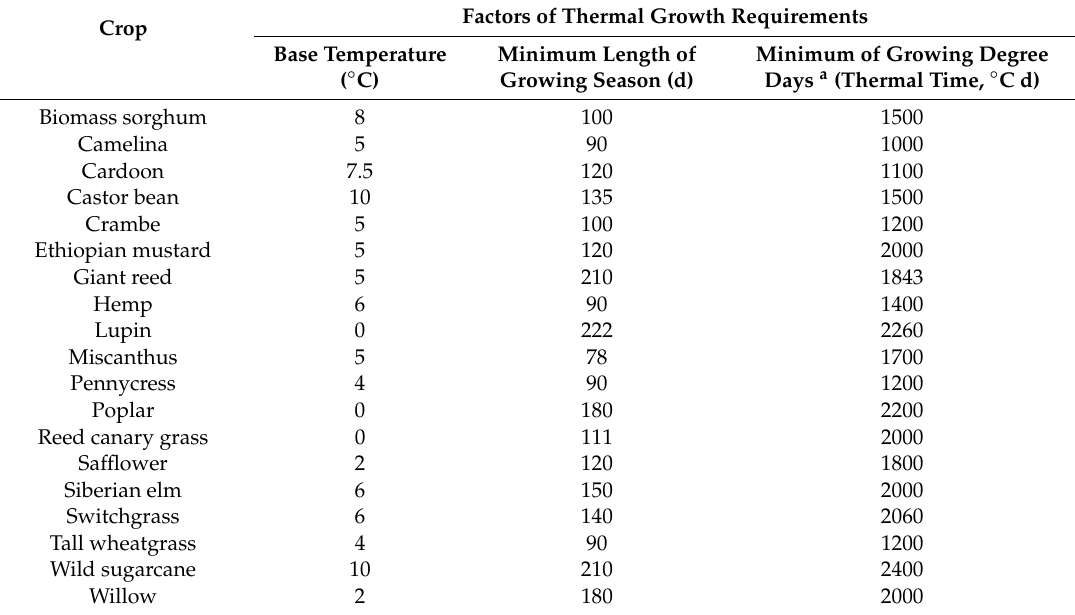
Table 3. Main thermal growth requirements of the 19 pre-selected industrial crops. Factors of Thermal Growth Crop